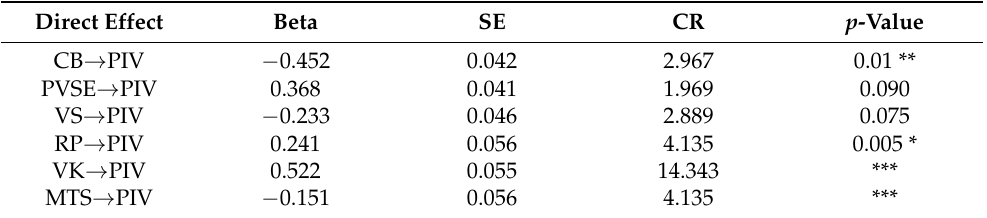
Table 5. Standardized coefficient estimates for paths predicting parents’ intention towards their kid’s COVID-19